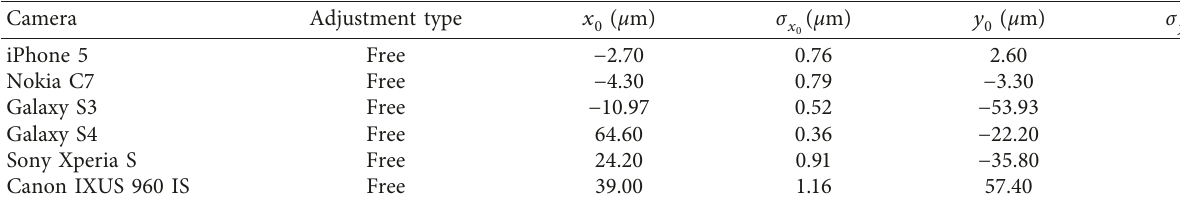
Table 3: Principal point offsets.